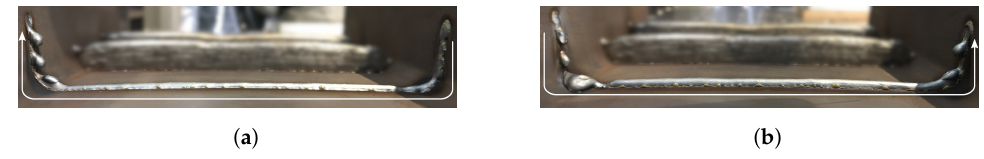
Figure 16. Two layers with slicing from outside to inside ( a ) Layer 1; ( b ) Layer 2.